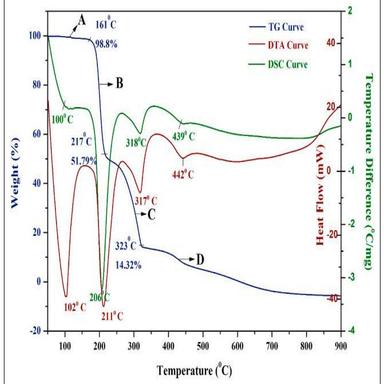
TG/DTA/DSC curves of GuHM.